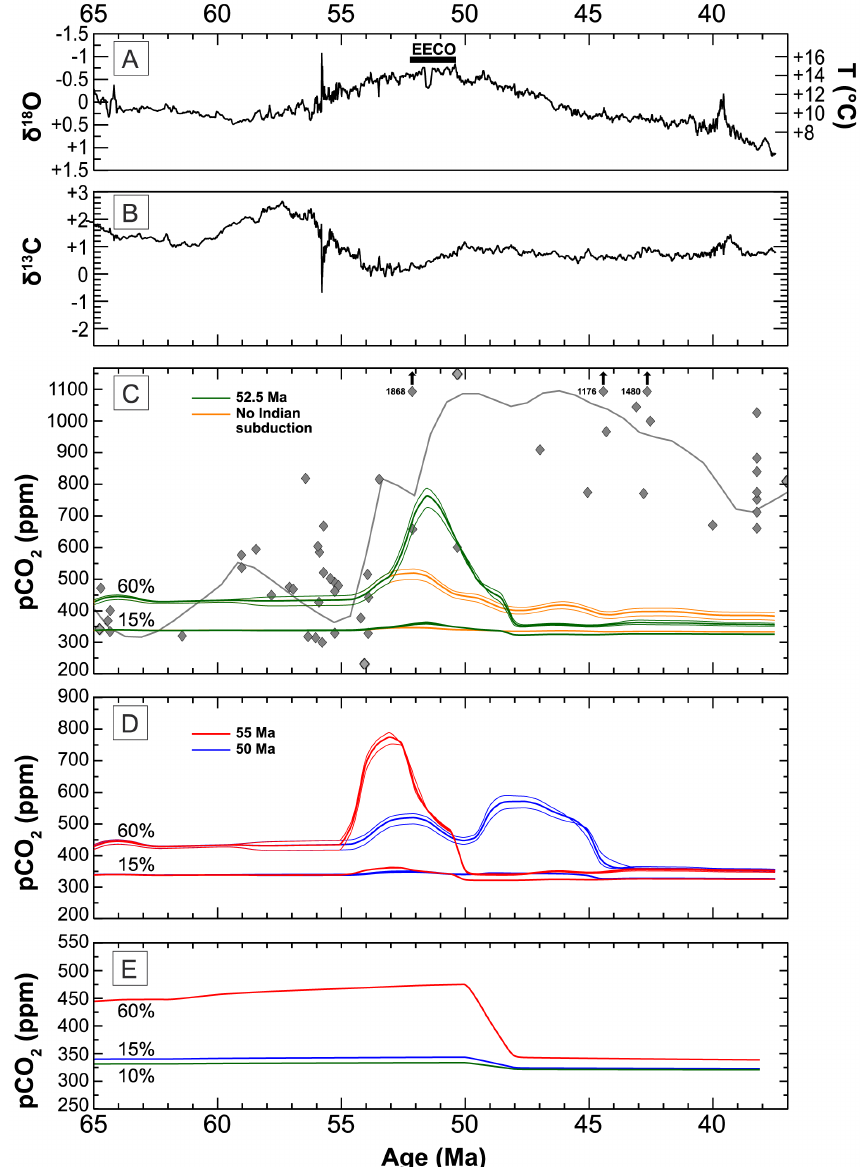
Figure 5. (a, b) Global oceanic benthic δ 18 O (a) and δ 13 C (b) foraminiferal compilation based on data from Cramer et al. (2009). Data were smoothed using a 10-point running average. Temperatures calculated from δ 18 O values assume an ice-free world (after Komar et al., 2013). (c) GEOCLIM modeling results of atmospheric p CO 2 resulting from excess CO 2 release associated with Neo-Tethys closure using plate velocities calculated from van Hinsbergen et al. (2011a), for 15 and 60% decarbonation efficiencies. Orange curves assume no Indian continental subduction, green lines correspond to an initiation of Indian continental subduction at 52.5Ma. Individual (gray diamonds) and mean (black line) atmospheric p CO 2 recorded by paleoproxies are also shown (from Beerling and Royer (2011)). Black arrows and associated number refer to p CO 2 values too high to be displayed. (d) Same as (c) but for an initiation of Indian continental subduction at 55Ma (red curves) and 50Ma (blue curves). (e) GEOCLIM modeling results of atmospheric p CO 2 resulting from excess CO 2 release as calculated from data of Kent and Muttoni (2013) using efficiencies of 10, 15 and